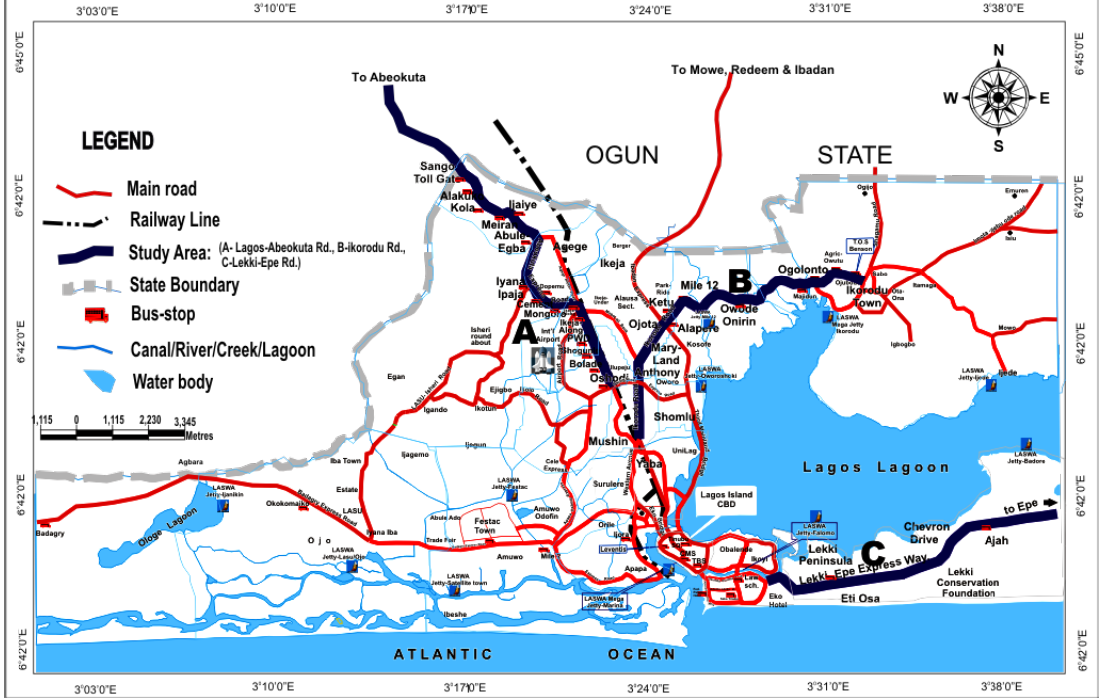
Figure 1: Metropolitan Lagos Showing the Study Area (A, B & C) and Other Road Highways